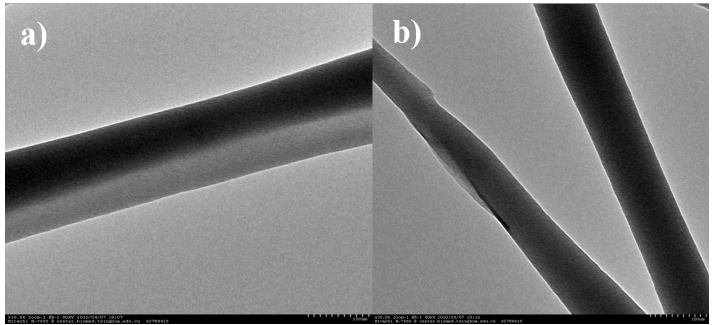
Figure 2. TEM images of ( a ) one piece of aLGN nanocomposites; ( b ) two pieces of aLGN nanocomposites. Materials 2017 , 10 , 443